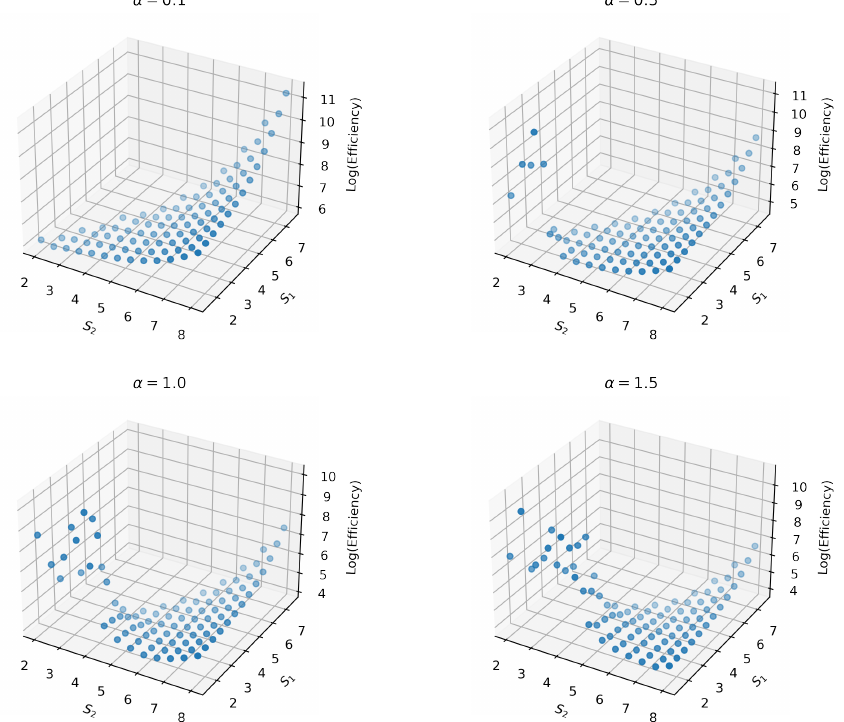
Figure 13. The maximum efficiency as a refrigerator of the Otto cycle that works among two adiabatic curves, s 1 < s 2, is displayed in the figure for the asymmetry parameter α = 0.1,0.5,1, and